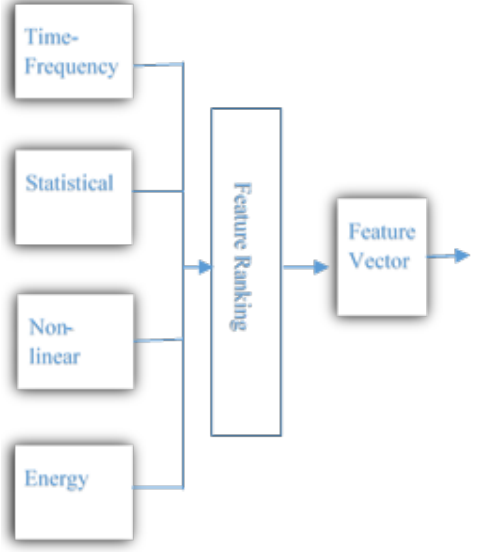
Figure 8. Feature extraction stage.